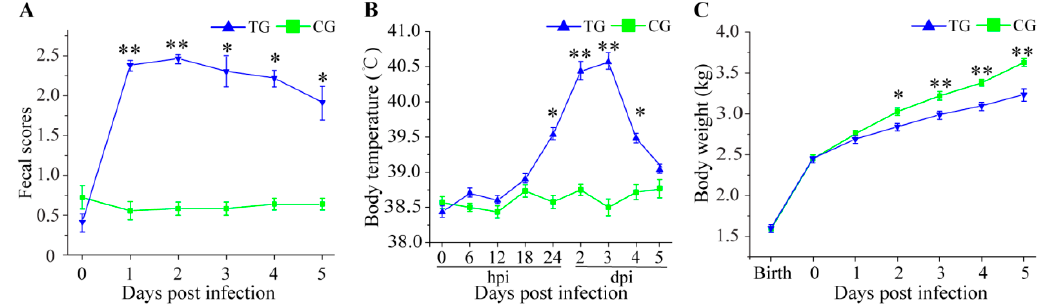
Figure 1. Clinical condition of piglets infected with C. perfringens type C. ( A ) Fecal scores from C.